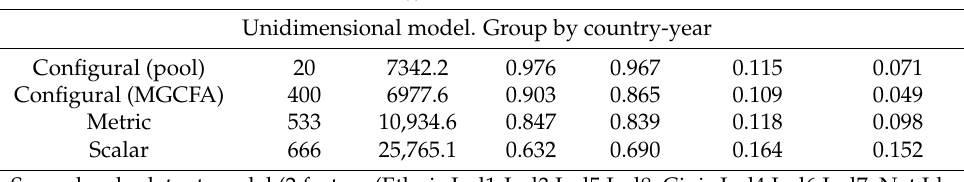
Table 3. Fit indices that test the configural (pool and multi-group), metric, and scalar equivalence.